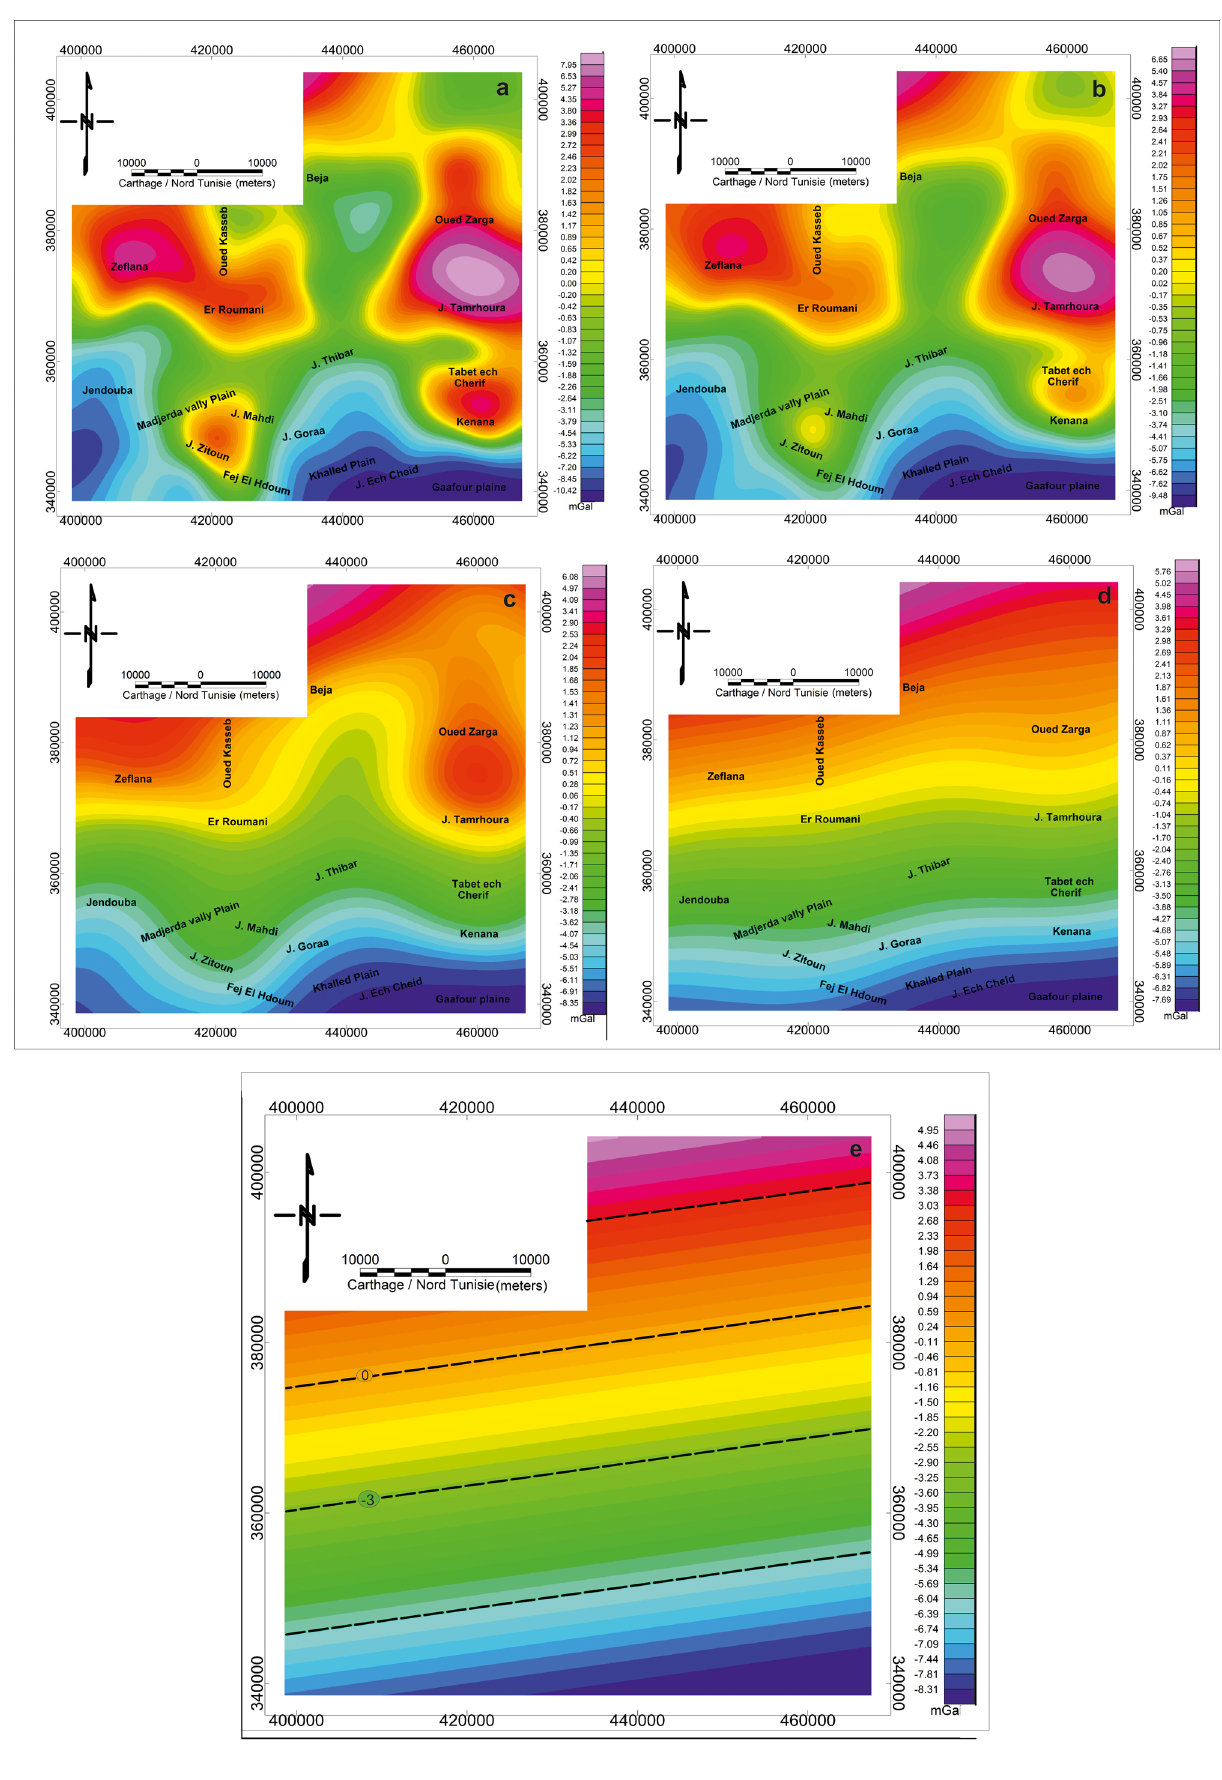
Figure 6. Upward continuation maps: (a) at 3000 m; (b) at 5000 m; (c) at 10,000 m; (d) at 20,000 m; (e) at 22,000 m (Regional anomaly